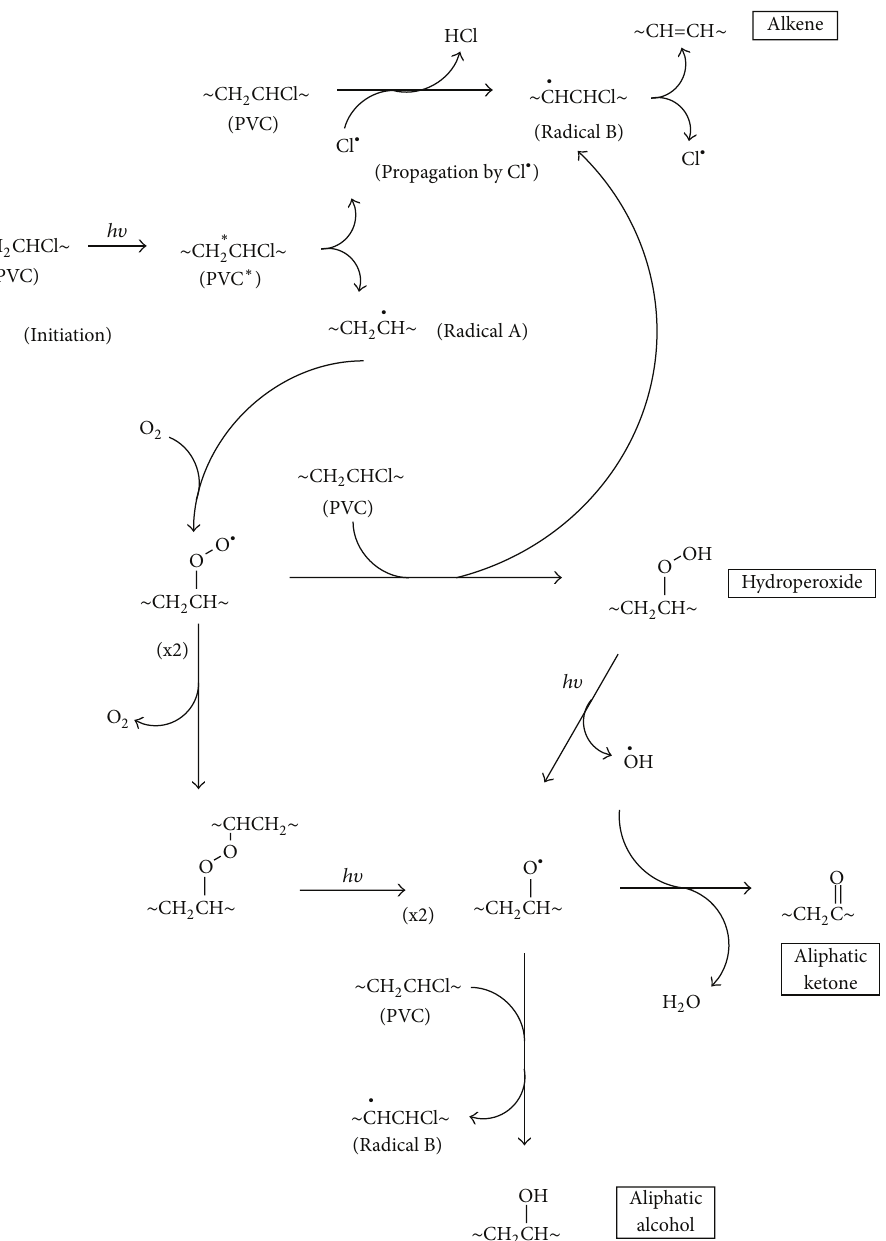
Scheme 3: Some of the photooxidation processes of PVC: reactions of radical B with molecular oxygen, akin to those of radical A, would give rise to chloroketone, chloroalcohol, and chlorohydroperoxide moieties; further reactions of such reactive functionalities may lead to chain cleavage and reduction in molecular